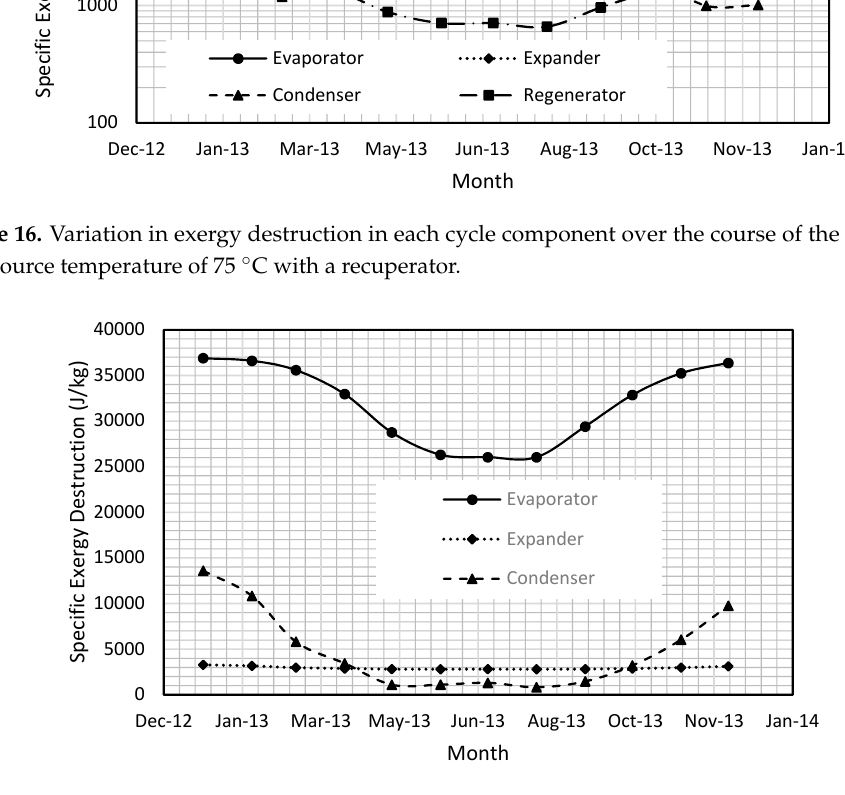
Figure 17. Variation in exergy destruction in each cycle component over the course of the year for a heat source temperature of 75 °C without a recuperator.